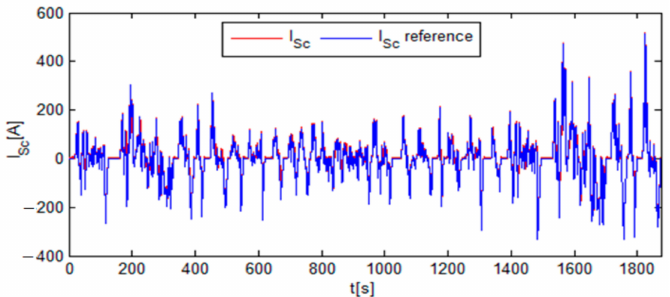
Figure 16. Current of the Sc corresponding to high frequency component.